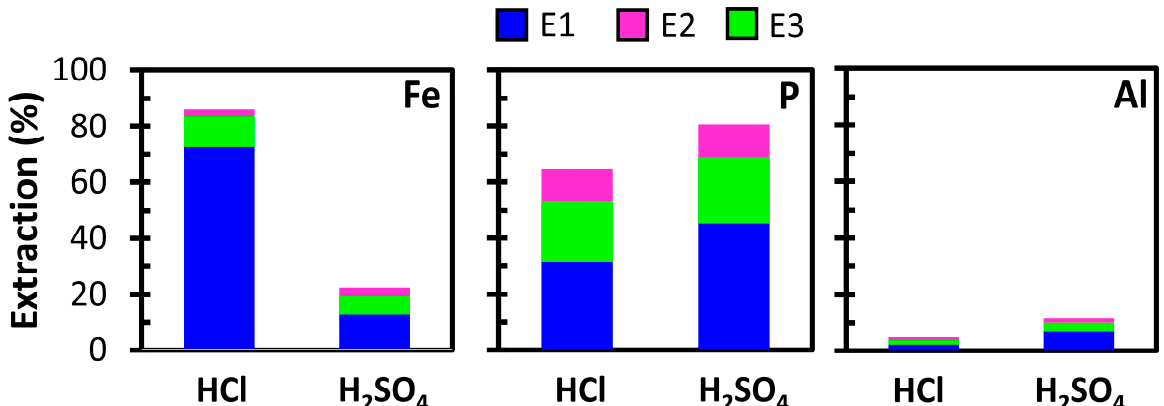
Figure 5. Extraction yields of Fe , P and Al from acid phase obtained with crossflow extractions by HCl and H 2 SO 4 , after each of the three sequential extractions (E1, E2, and E3) with isoamyl alcohol. In all extractions, the ratio between organic phase and acid phase was 1:1. The analysis on samples was performed by ICP-OES.